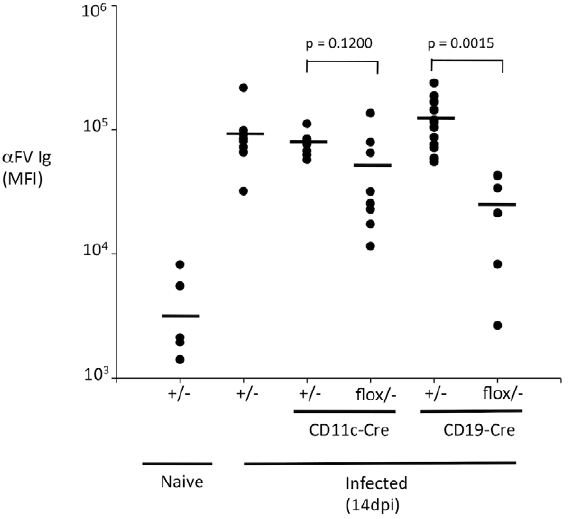
Figure 2. B cell-intrinsic TLR signaling is required for an antibody response to FV. Myd88 germline heterozygous mice ( + / 2 ) and mice with Myd88 deleted in DCs (CD11c-Cre/ Myd88 flox/ 2 ) or B cells (CD19-Cre/ Myd88 flox/ 2 ) were infected with FV, and FV-specific Ig levels in the serum determined at 14 dpi by staining of envelope expressing cells and flow cytometry. Units represent the mean fluorescence intensity (MFI) of cells stained with diluted serum, followed by allophycocyanin conjugated. anti-mouse IgG(H + L). Each dot represents an individual mouse.